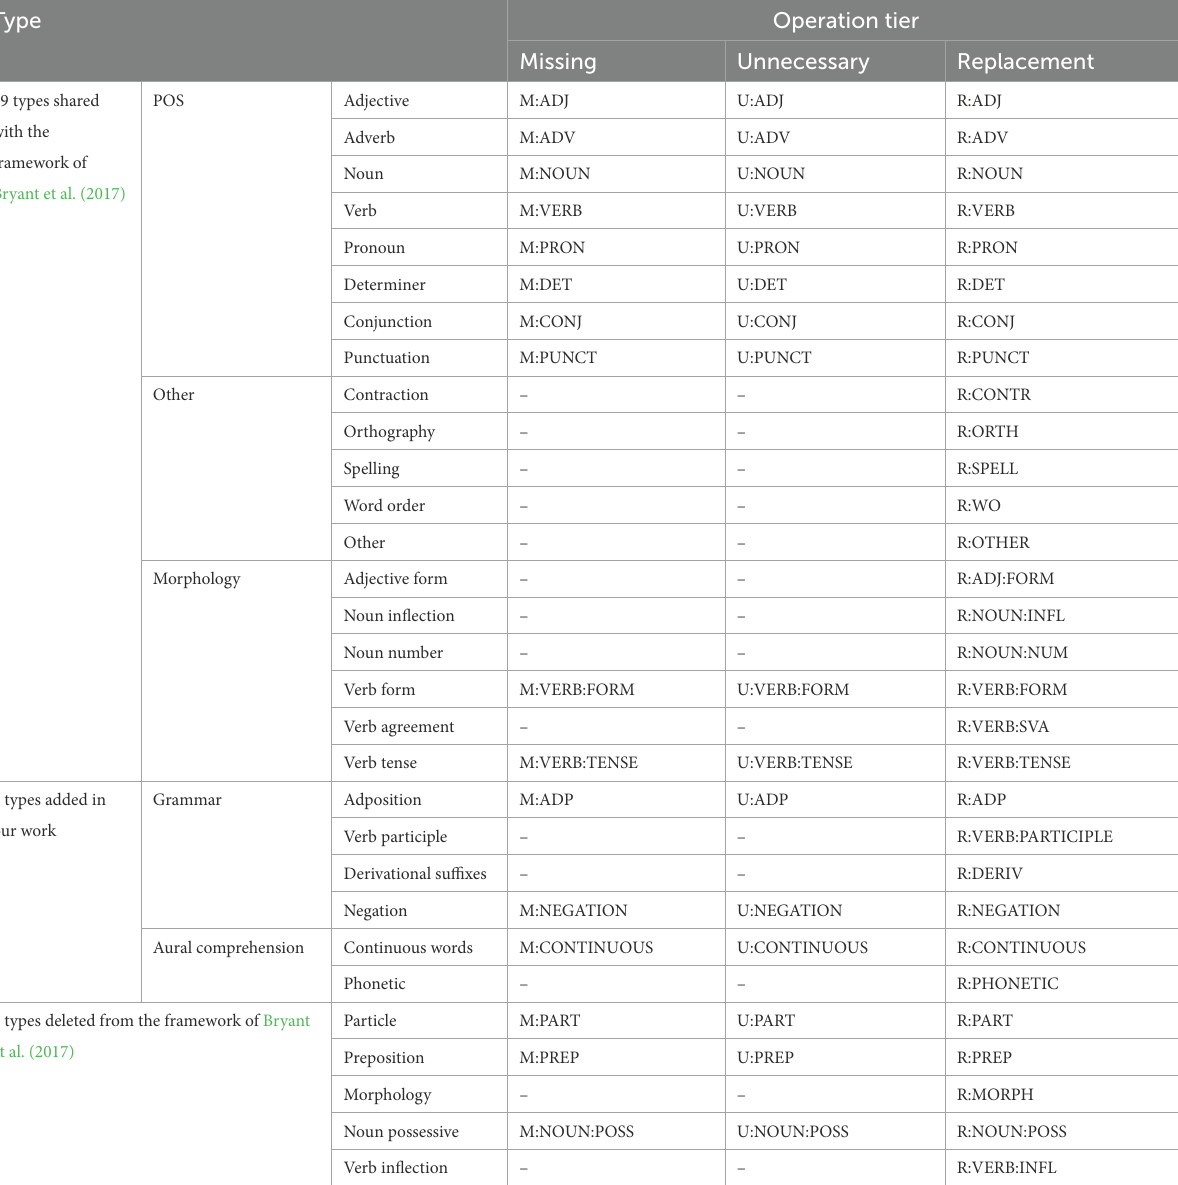
TABLE 2 Twenty-five error types in French dictation